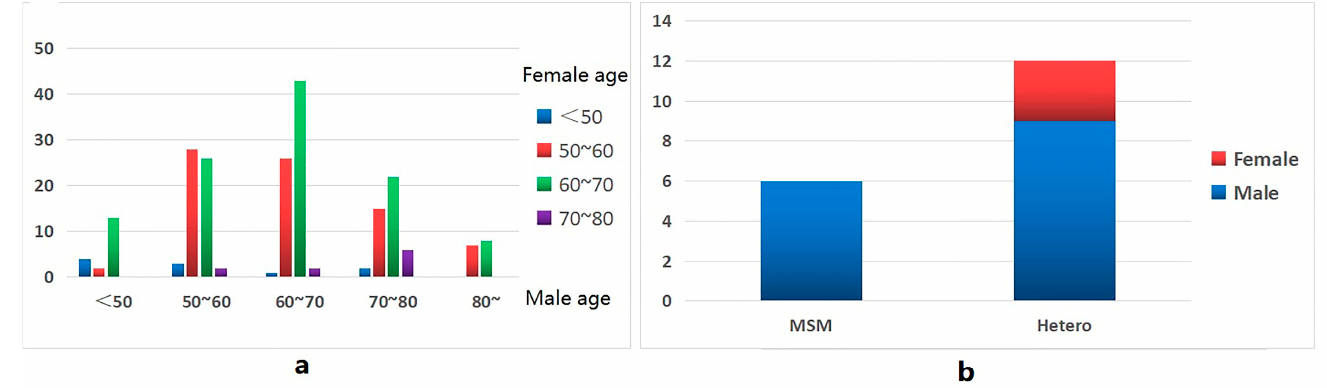
Figure 4. Propagation characteristic diagram of the molecular network. ( a ) Male and female connec- tions at different ages. ( b ) Connections between MSM and patients with heterosexual transmission and patients of other genders.